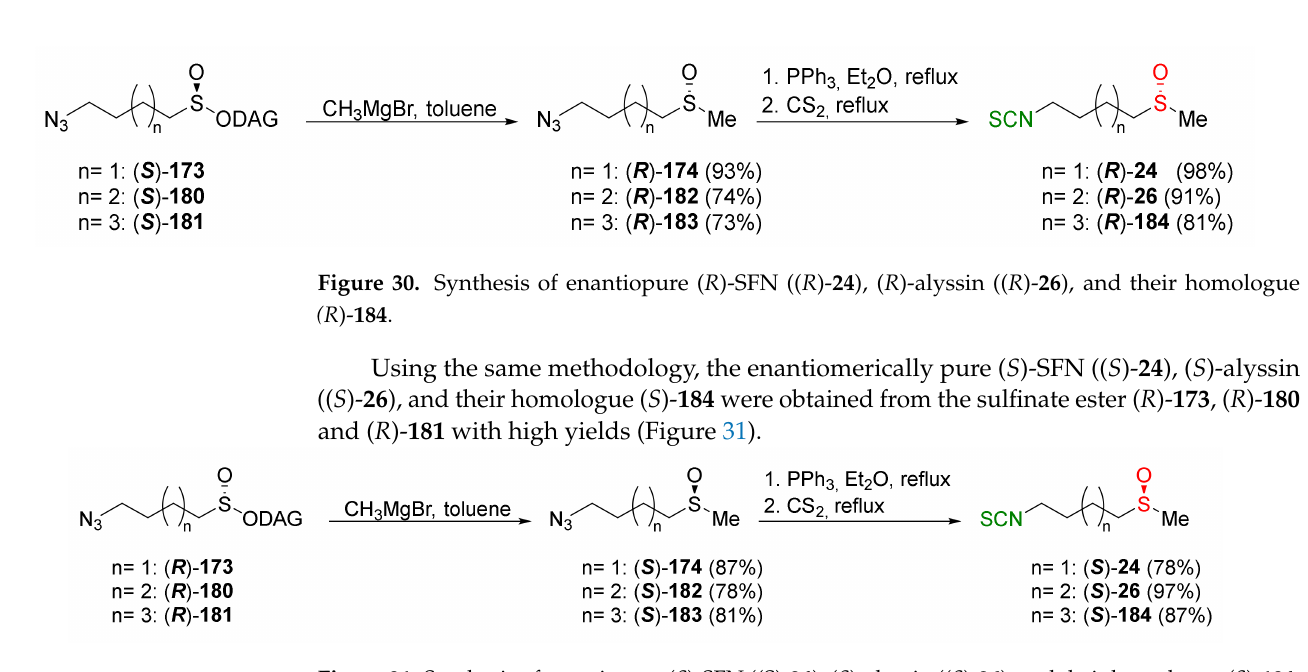
Figure 31. Synthesis of enantiopure ( S )-SFN ((S)- 24 ), ( S )-alyssin (( S )- 26 ), and their homologue (S )- 184 .